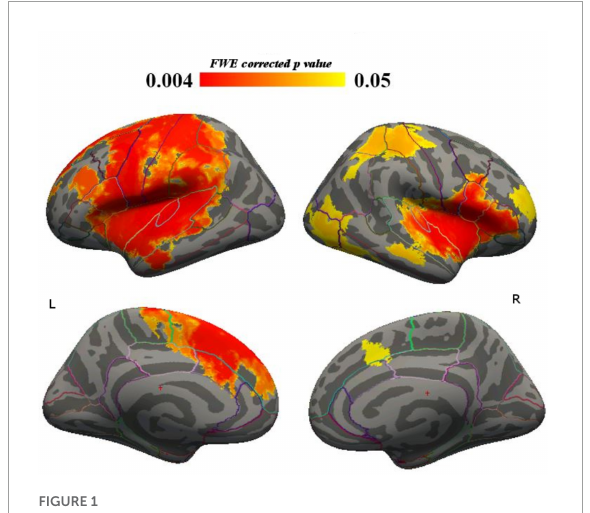
FIGURE1 Total BPRS—LGI correlation, whole